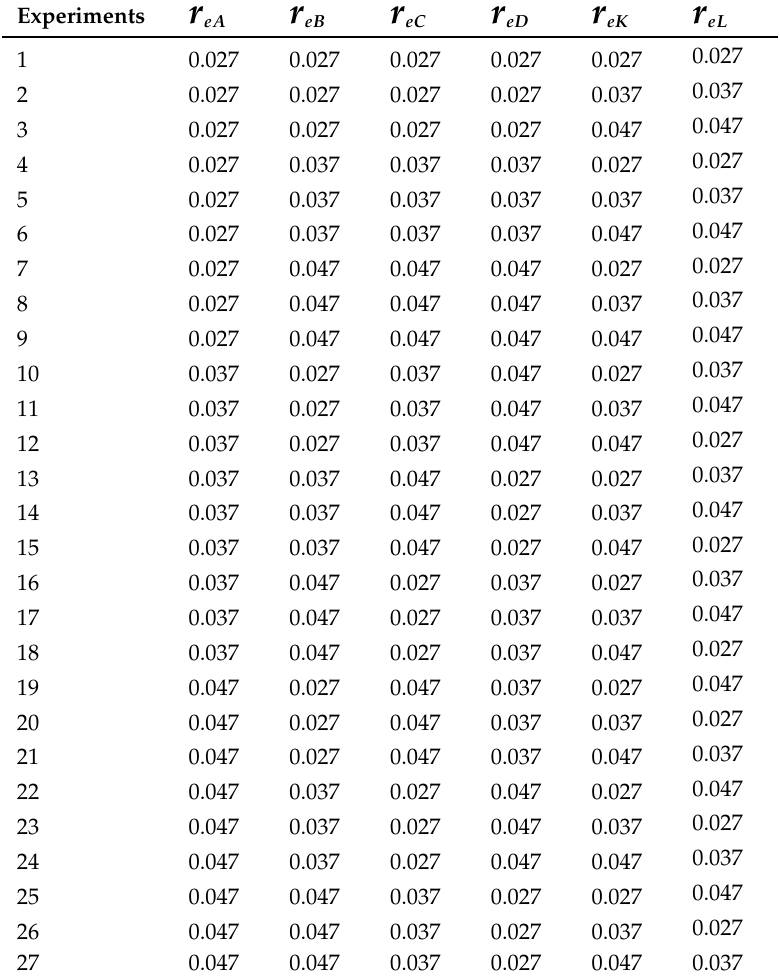
Table A1. Slider-crank